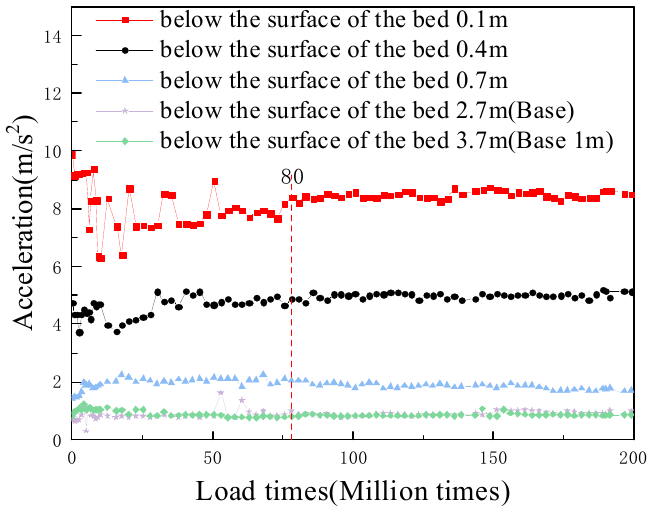
Figure 14. Variation law for vibrational acceleration with the number of vibrations.